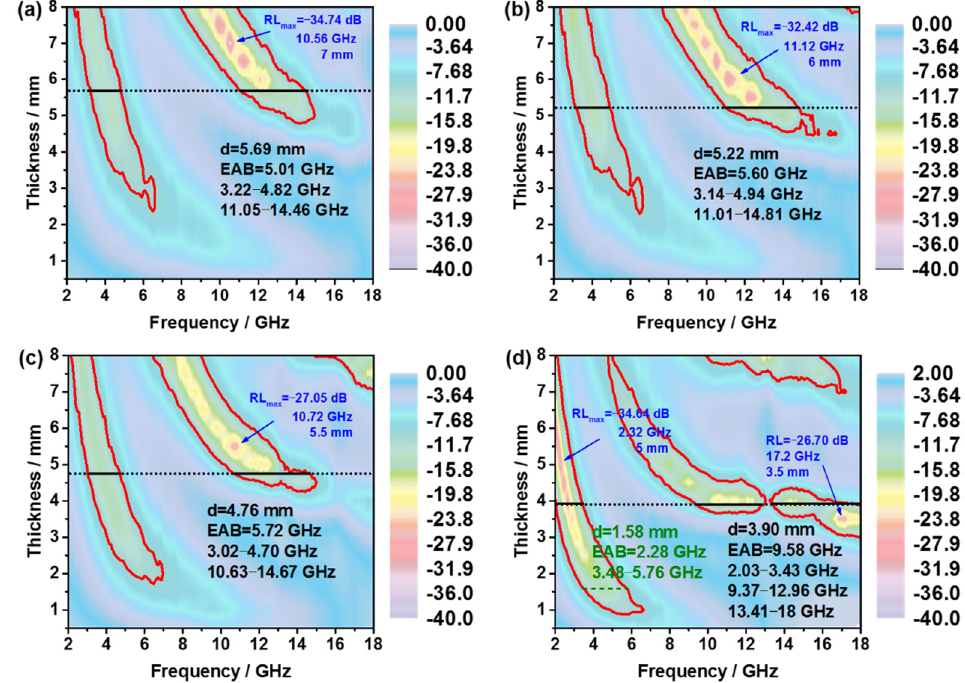
Figure 5. Electromagnetic wave reflection loss of C1 ( a ), C2 ( b ), C3 ( c ) and C4 ( d ).